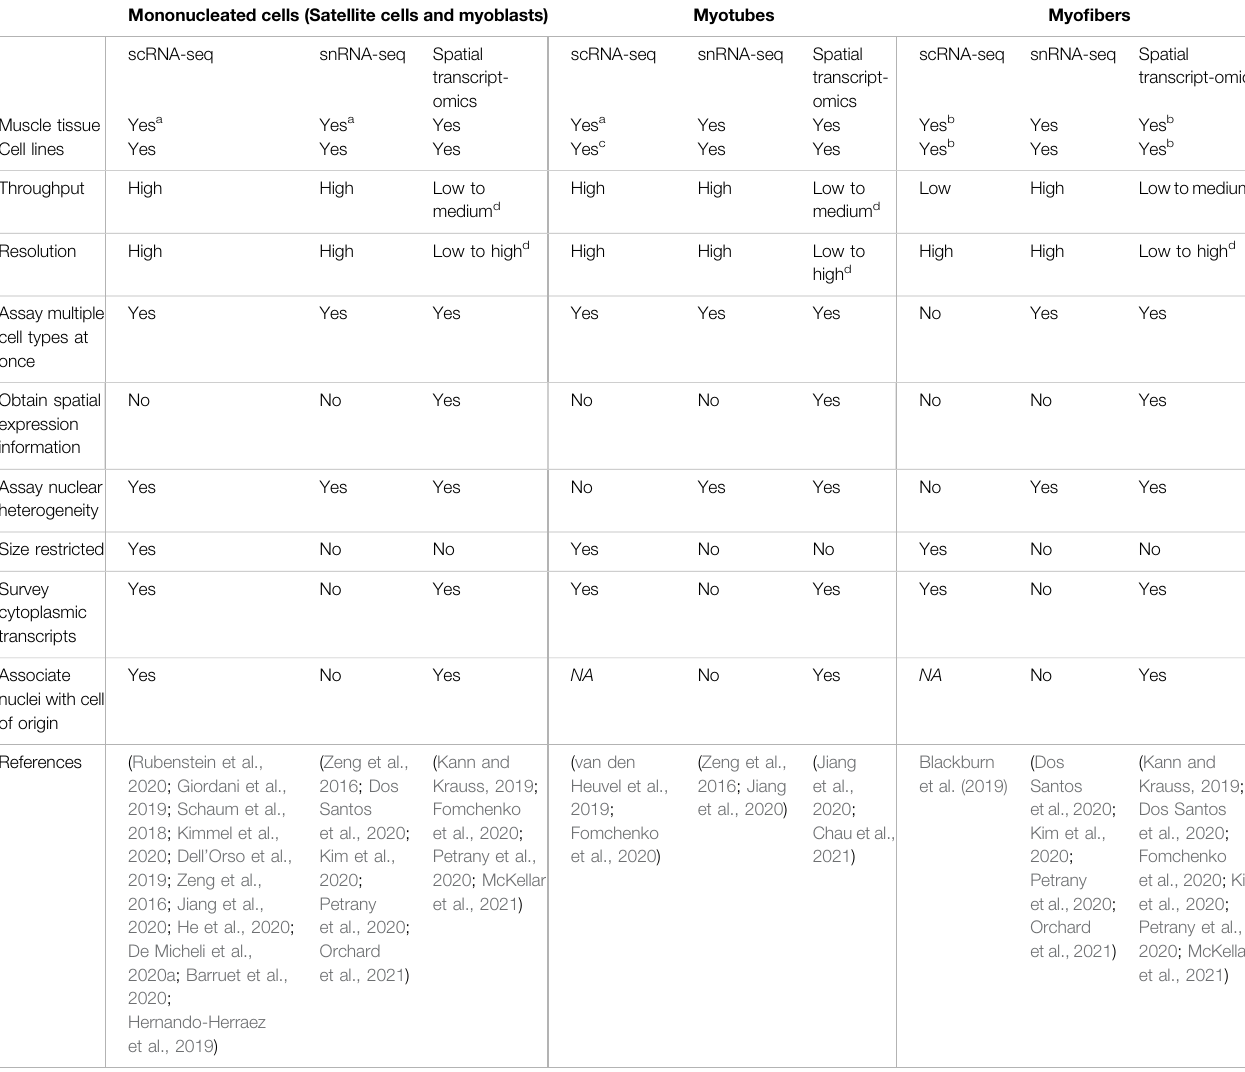
TABLE 1 | Advantages and limitations of high-throughput transcriptome methods for skeletal muscle cell types. Mononucleated cells (Satellite cells and